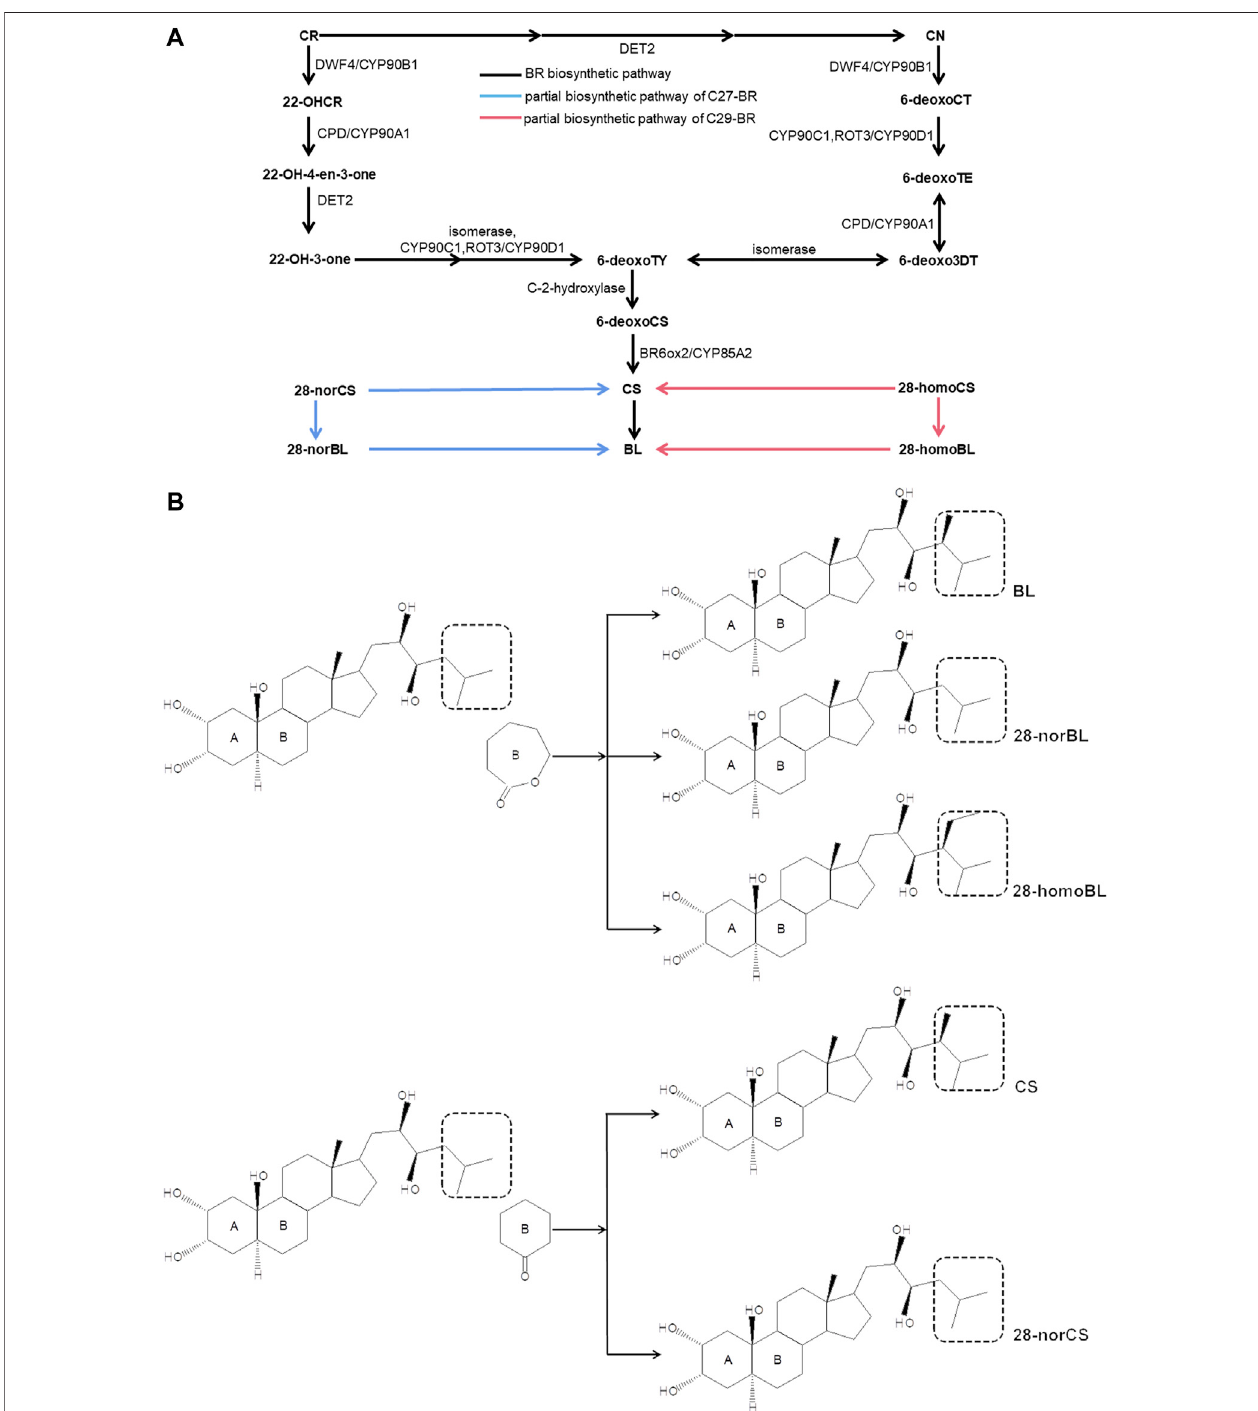
FIGURE 1 | BR biosynthetic pathway. (A) BR biosynthetic pathway. (B) Structure of fi ve BR (CS, 28-norCS, BL, 28-norBL, 28-homoBL). Campesterol (CR); campestanol (CN); 6-deoxocathasterone (6-deoxoCT); 6-deoxoteasterone (6-deoxoTE); 3-dehydro-6-deoxoteasterone (6-deoxo-3-DT); 6-deoxotyphasterol (6-deoxoTY); (22S)-22-hydroxycampesterol (22-OHCR); (22S,24R)-22-hydroxyergost-4-en-3-one (22-OH-4-en-3-one); castasterone (CS); brassinolide (BL); 28-norcastasterone(28-norCS);28-homocastasterone(28-homoCS);28-norbrassinolide(28-norBL); and 28-homobrassinolide (28-homoBL).Theblackbox ofa dashed line in the left could be replaced by the one in the right within the same brace in (B) .